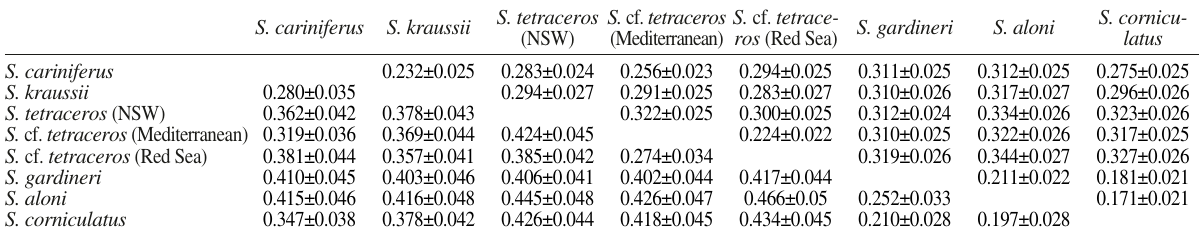
Table 2. – Estimates of evolutionary divergence between groups. The number of base substitutions per site (±standard error estimates) ob- tained from averaging over all sequence pairs between groups are shown. P-distances are shown above the diagonal and K2P distances below the diagonal. Analyses were conducted using MEGA X (Kumar et al. 2018).